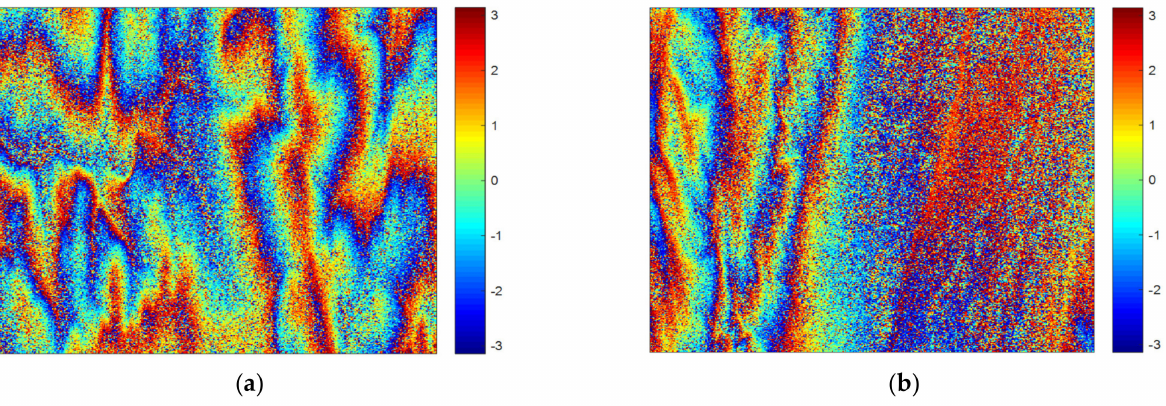
Figure 9. The measured interferograms: ( a ) Area A with high coherence; ( b ) area B with low